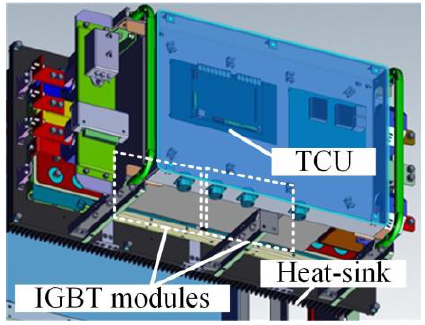
Figure 21. The back-to-back towing test platform with ( a ) overall view of the test platform and ( b ) side view of the test platform.